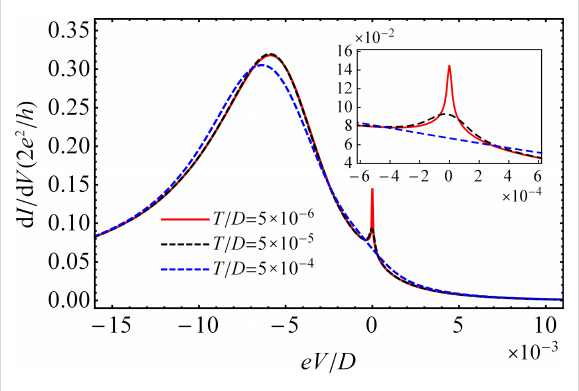
Figure 5: Differential conductance d I /d V as a function of the bias voltage eV with μ R / D = − 0.022 at three different temperatures in absence of a magnetic field. The remaining parameters are the same as those in Figure 3b.